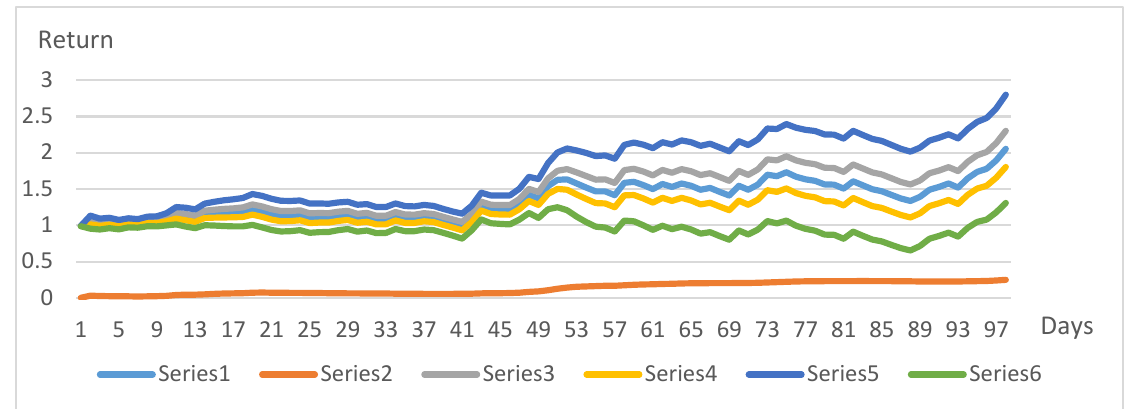
Figure 4. Experimental portfolio return confidence intervals in the US during the 2007–2008 financial crisis (source: compiled by the authors based on Yahoo Finance data and own calculations).